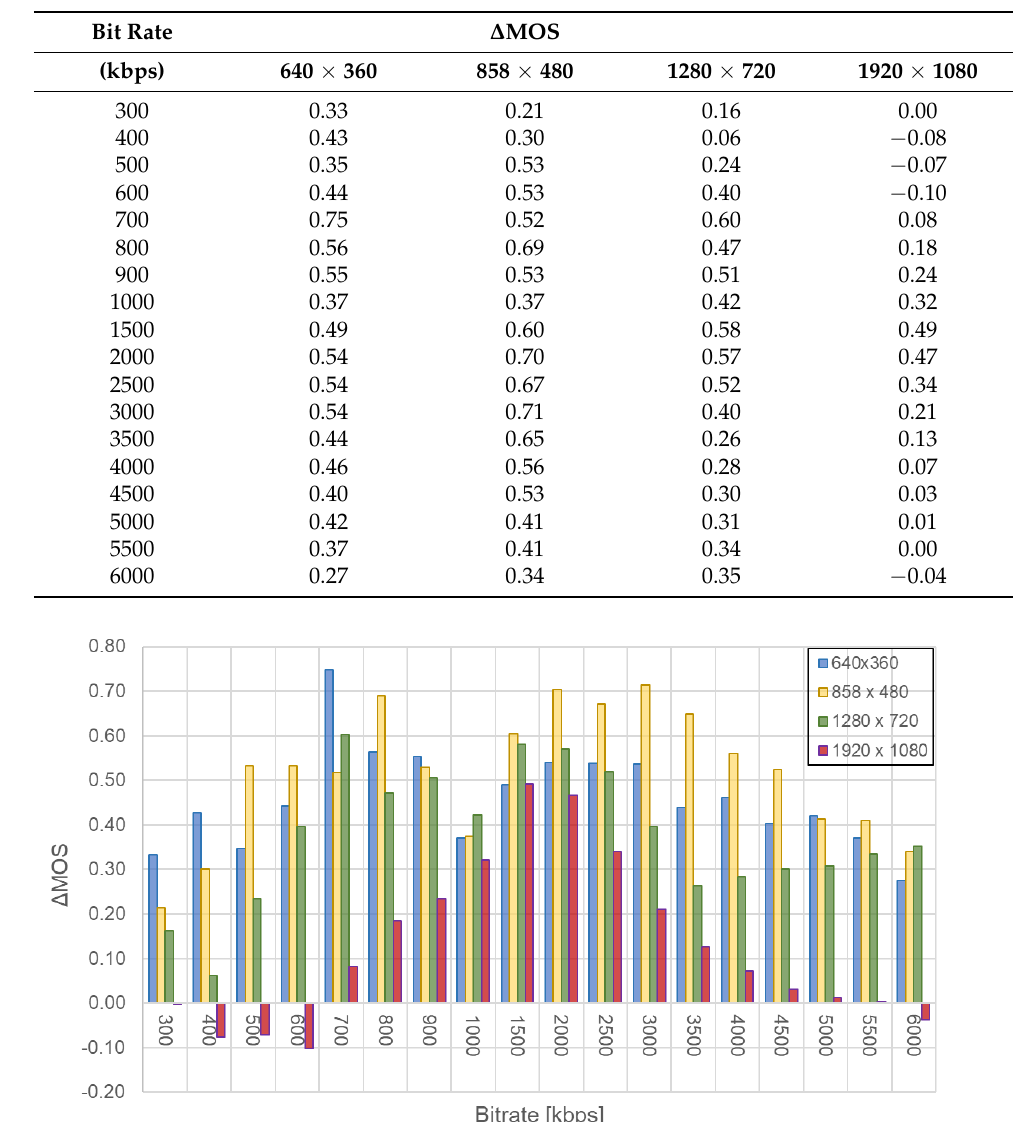
Table 3. Value of the difference in ∆ MOS (for H.264 codec) between the results obtained under laboratory and home conditions.